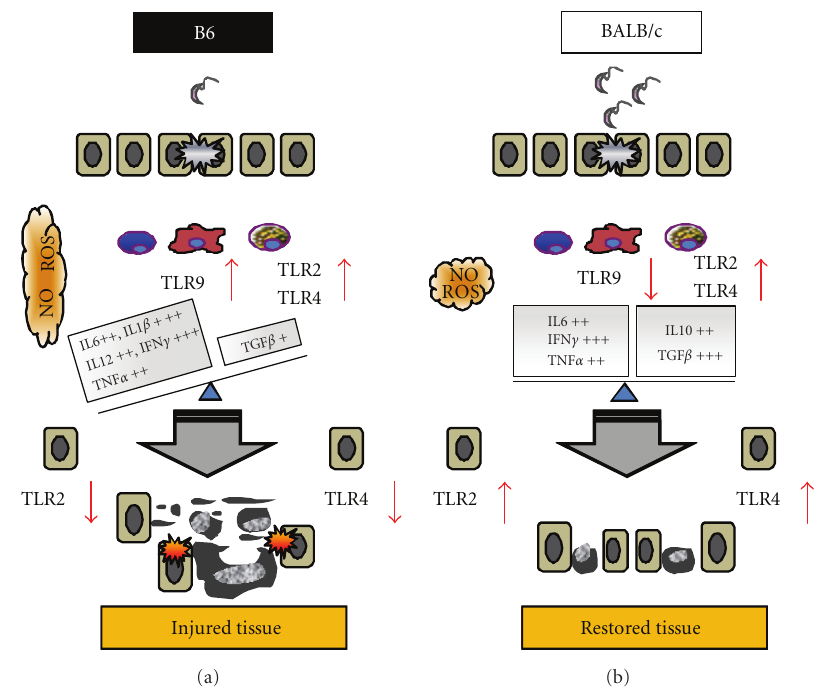
Figure 3: Comparative analysis of hepatic injury, inflammation and TLR expression in Trypanosoma cruzi- infected B6 and BALB/c mice. The parasitemia was higher in BALB/c than B6 mice. However infected B6 mouse strain showed stronger and injurious inflammatory environment (increased NO and ROS) associated with high levels of TLR2, TLR4, and TLR9 in hepatic leukocytes. In contrast, BALB/c mice displayed more balanced proinflammatory/immunoregulatory cytokines profile during the acute infection. Furthermore, TLR2 and TLR4 were upregulated in infiltrating leukocytes and hepatocytes as well, while TLR9 expression was low in hepatic leukocytes of infected BALB/c mice. Altogether the results suggested that the strong inflammatory environment elicited in infected B6 mice plus the loss of TLR2 signaling may be responsible for the severity of the hepatic injury and higher mortality of this mouse strain [19,